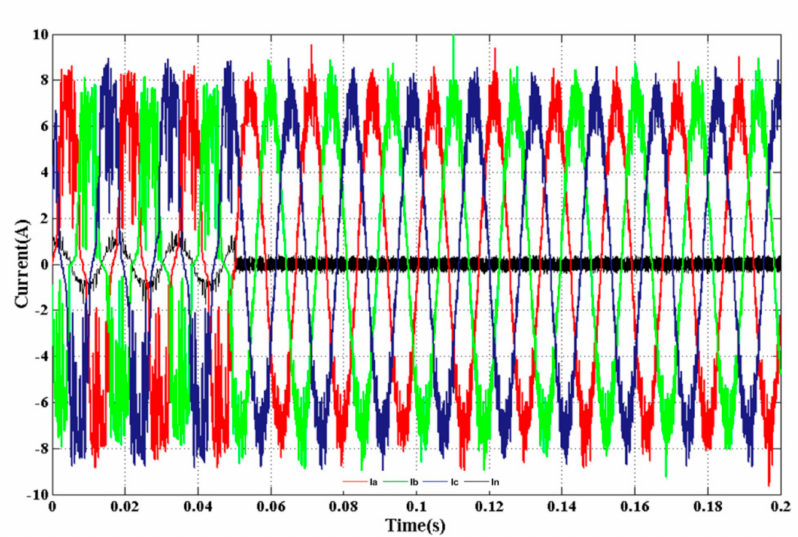
Figure 5. Experimental result of the traditional p-q method for case